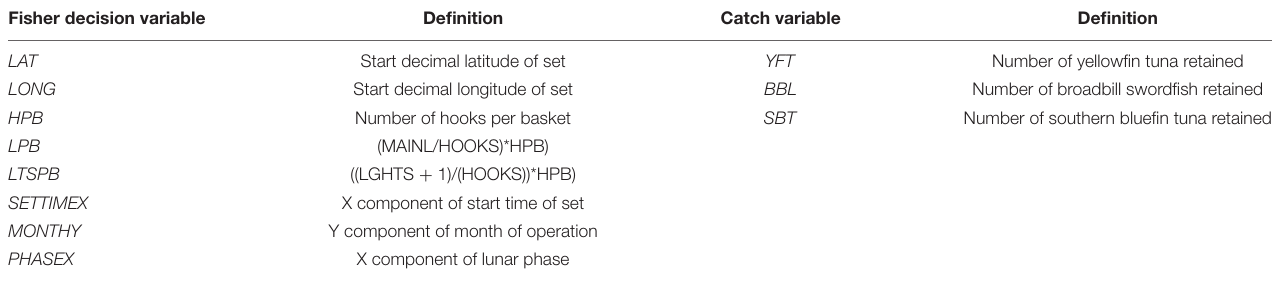
TABLE 2 | The set of 11 fisher decision and catch variables that were retained following the analysis of their contribution to the métiers using feature selection